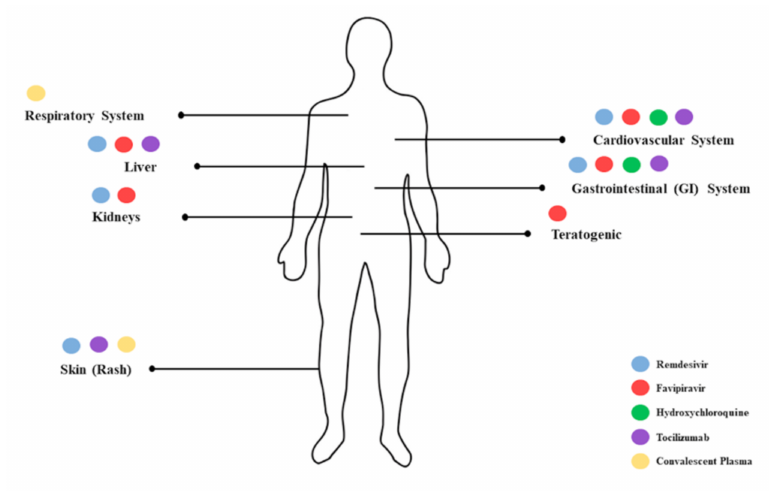
Figure 5. Summary of adverse events associated with the administration of the five potential therapeutics in COVID-19